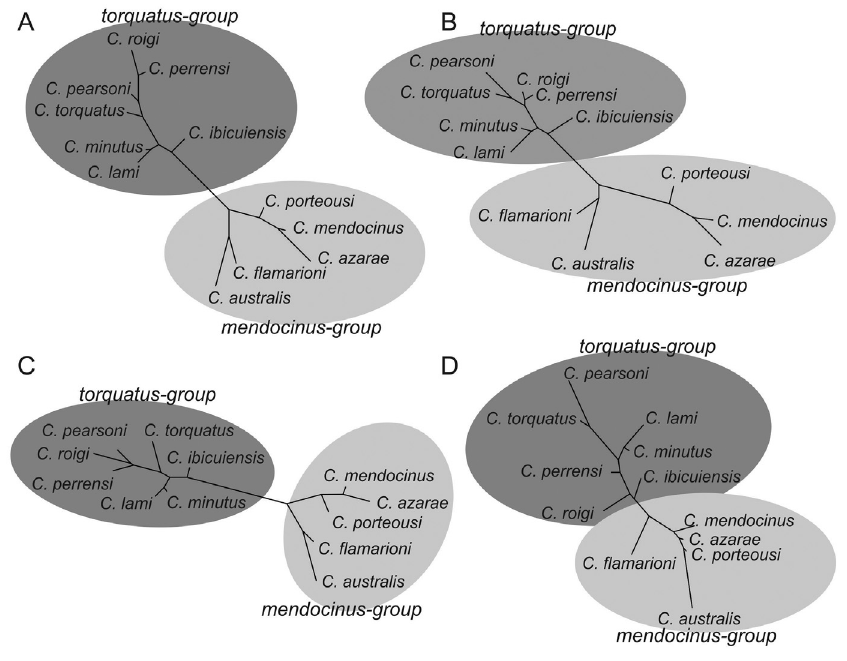
Figure 6 - Phenogram using neighbor-joining method and Mahalanobis distances from lateral view of the skull for 12 species of Ctenomys from the mendocinus and torquatus